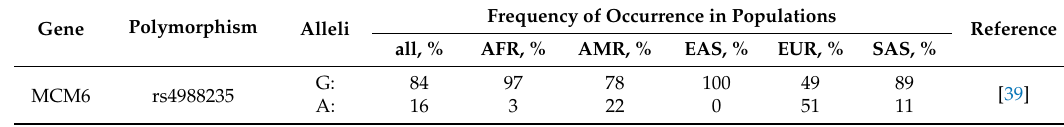
Table 2. Population genetics of genes responsible for lactose